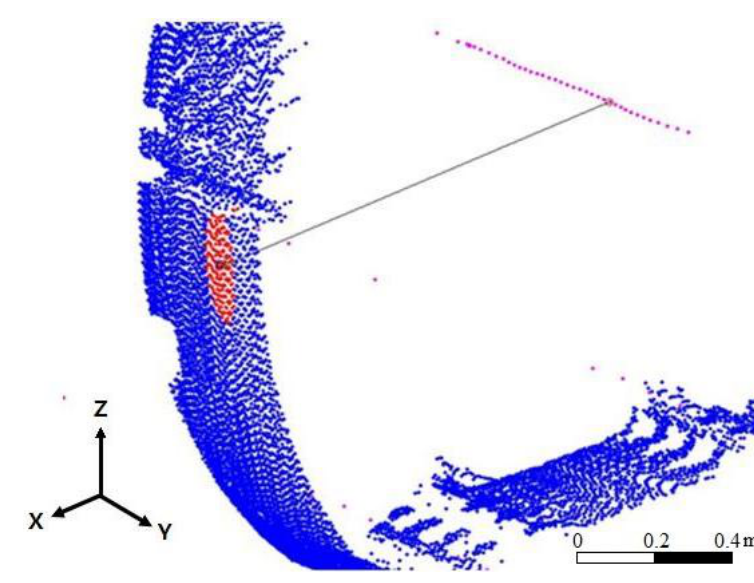
Figure 6. Cross-sectional point